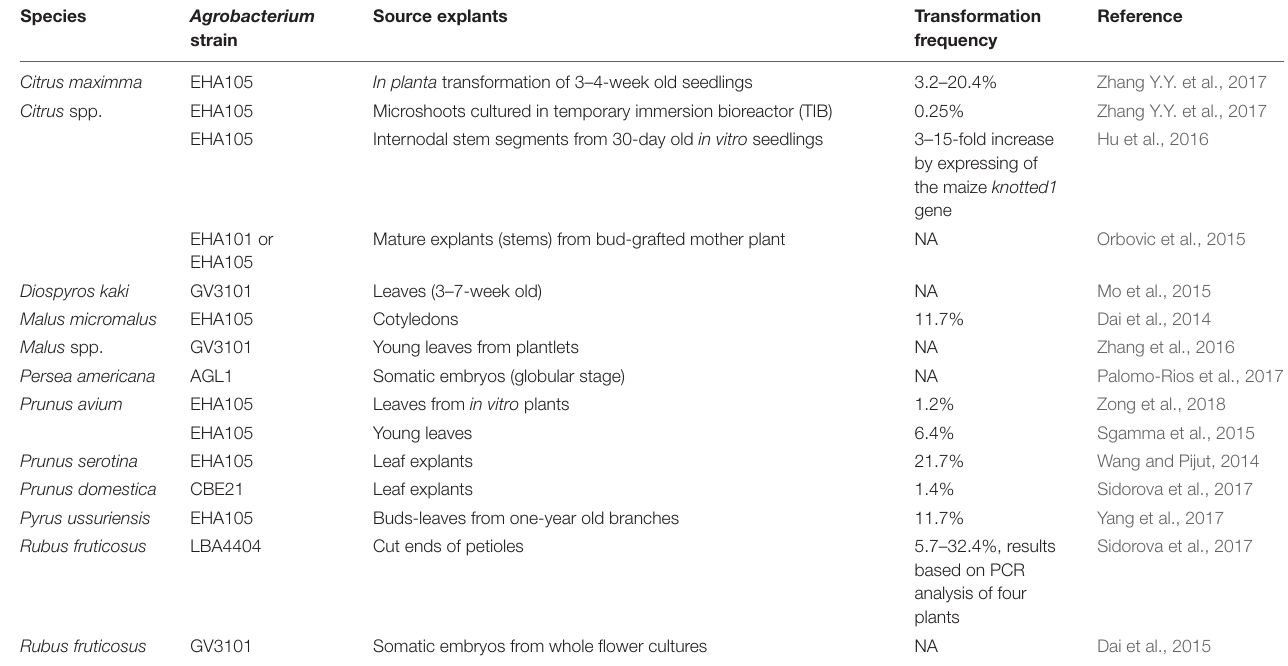
TABLE 1 | Recent successes (2014-present) in Agrobacterium tumefaciens -mediated transformation of F&N crops for transformation technology development.